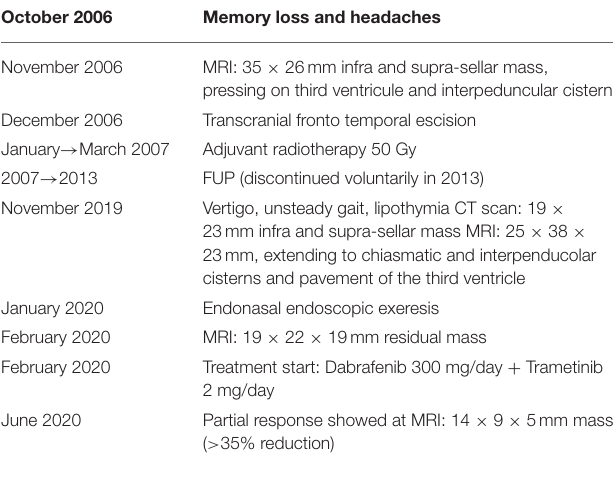
TABLE 1 | Timeline of patient clinical history.